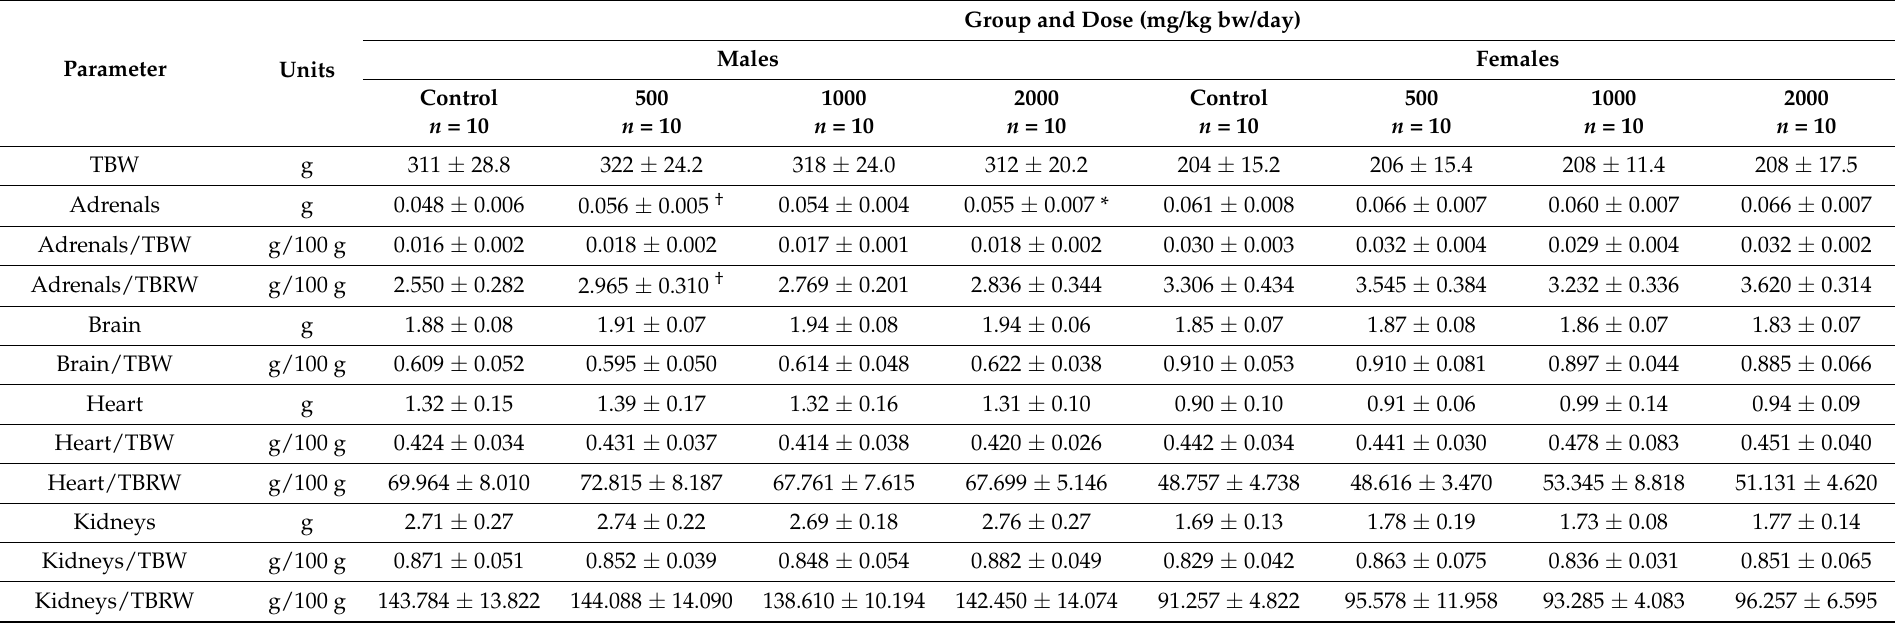
Table 6. Effect of 14 day oral administration of B. subtilis MB40 on organ weights of male and female